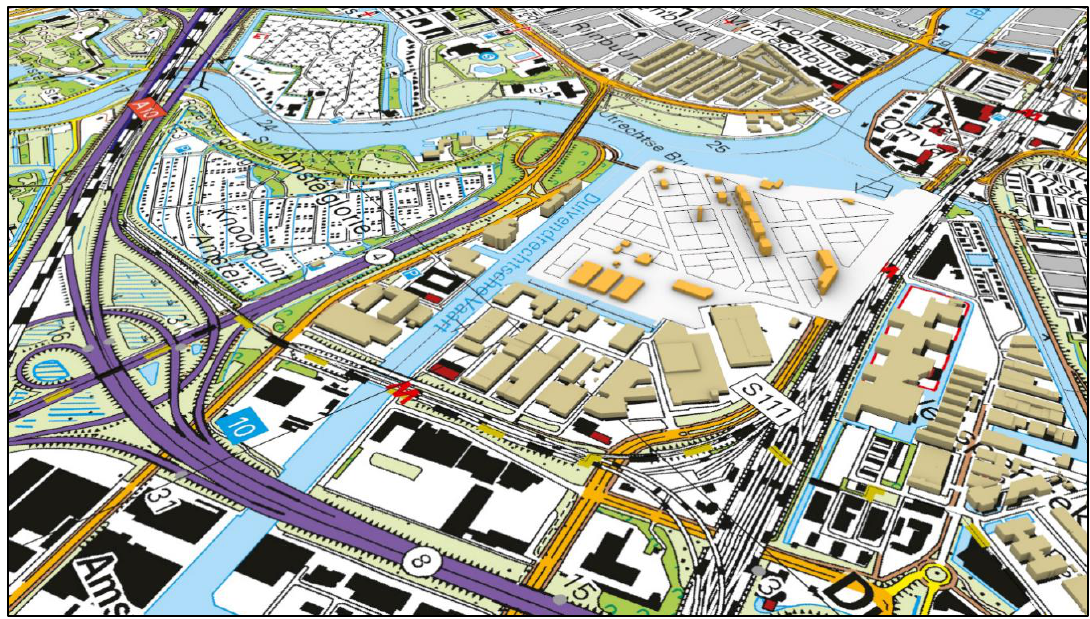
Figure 23. Example of visualization of additional contextual information during the design process in Rhinoceros/Grasshopper.